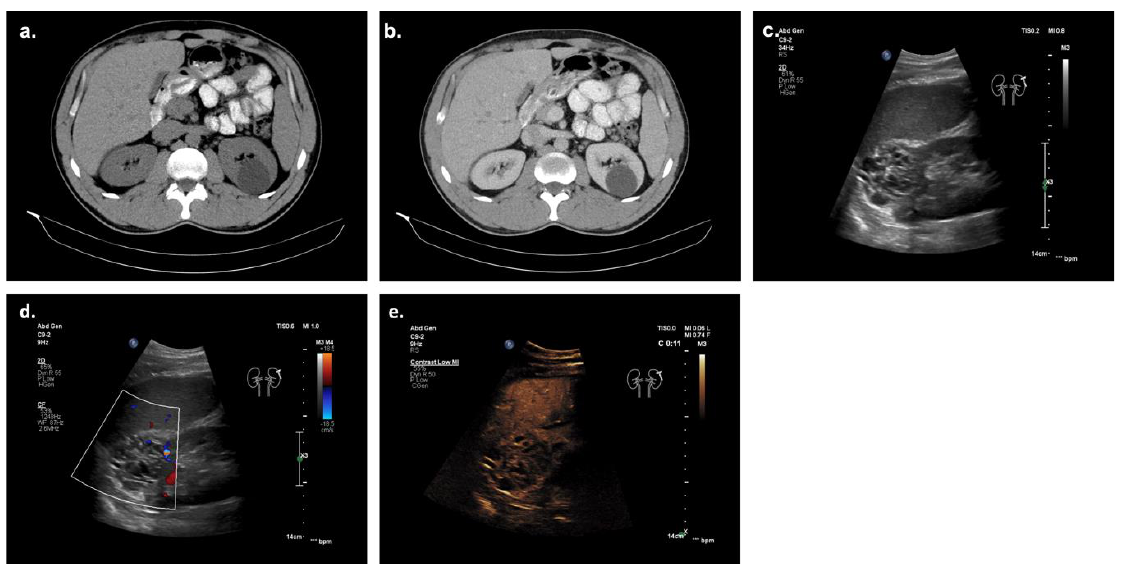
Figure 4. Patient from our institution undergoing diagnostic workup of clear cell RCC. ( a ) Native CT showing a hypodense lesion in the left kidney without any signs of solid components. ( b ) CT in venous phase showing a hypodense lesion in the left kidney without contrast-uptake or nodular components. ( c ) B-mode ultrasound of the left kidney shows a partly hypo- and partly hyperechoic lesion that does not fulfill the sonomorphological criteria for a cystic lesion. ( d ) Color doppler ultrasound of the lesion shows major vascularization inside the solid lesion. ( e ) CEUS of the solid lesion proves major vascularization of the solid lesion in the arterial phase with partly necrotic parts, which do not appear vascularized, in line with sonomorphological features of a malignant renal tumor. The diagnosis of clear cell RCC was confirmed histologically after surgical excision.